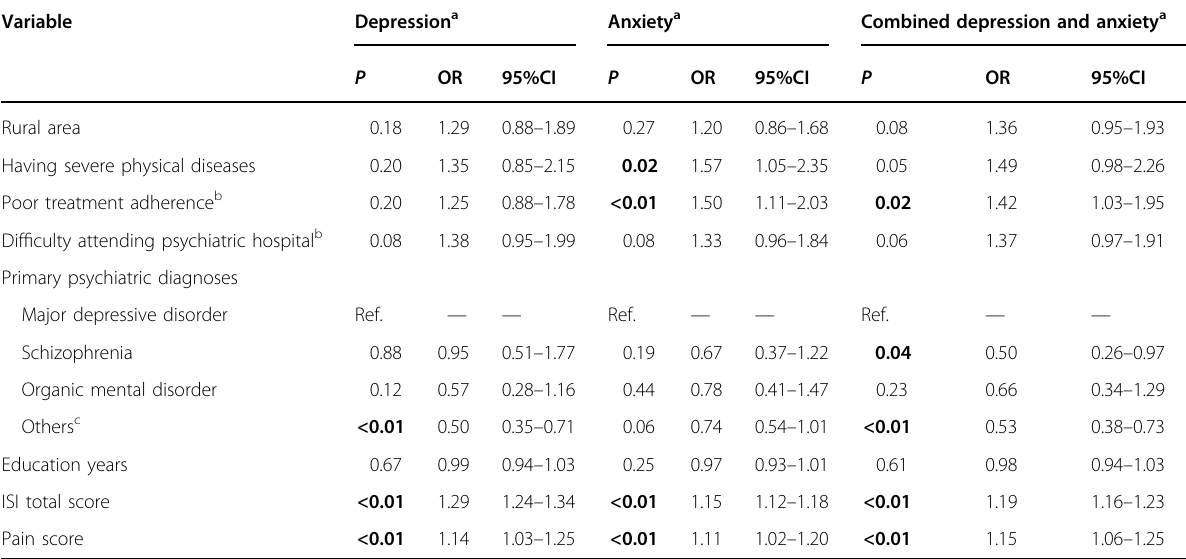
Table 2 Independent correlates of depression, anxiety, and combined depression and anxiety in older patients with psychiatric